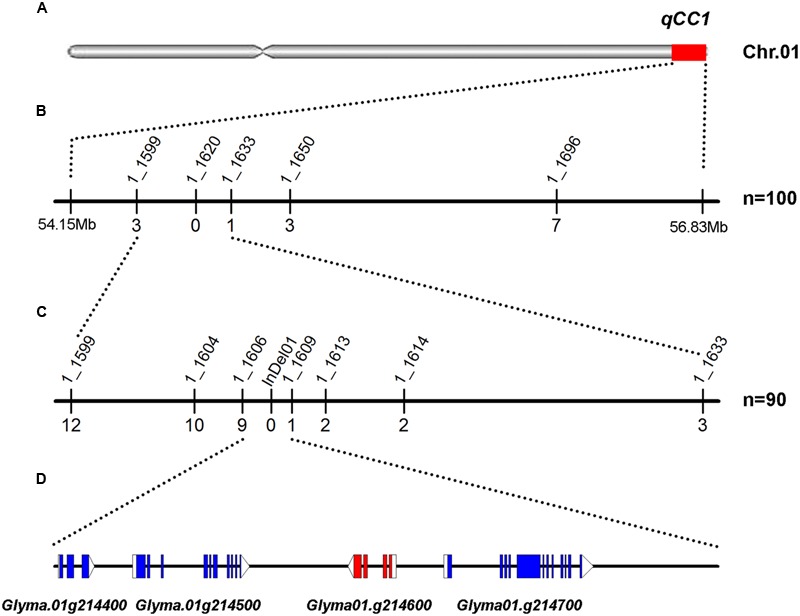
Mapping and fine mapping of the qCC1 locus. (A) Chromosomal location of qCC1 identified by NGS-based BSA on chromosome 1. (B) Coarse mapping of the qCC1 locus. Vertical lines indicate polymorphic SSR markers. Names of markers are shown above the line and the number of recombinants between qCC1 and each marker is shown below the line. (C) Fine mapping of qCC1 with genotyping data from newly developed polymorphic markers. (D) Candidate genes in the fine-mapping region. Blue/purple rectangles, blank rectangles, and blank triangles represent exons, 5′ UTRs, and 3′ UTRs, respectively.